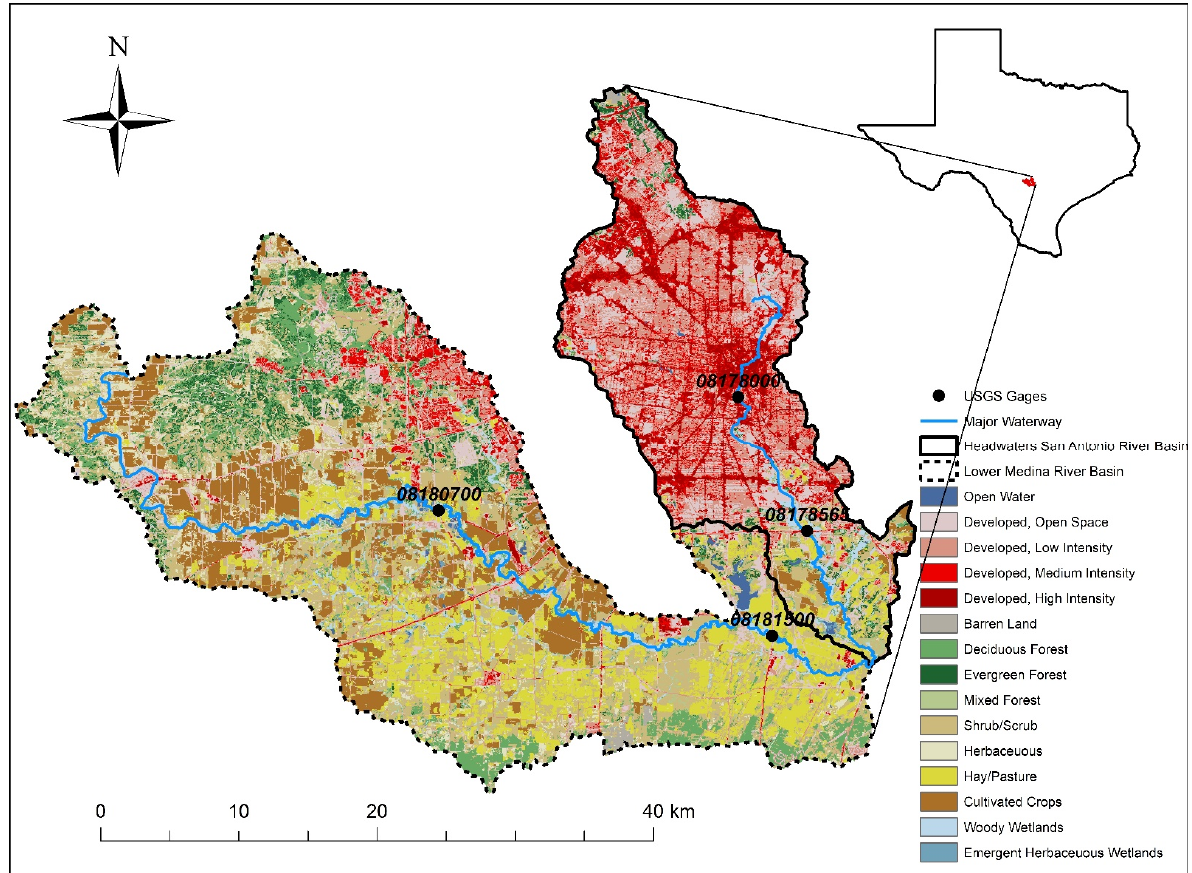
Figure 1. Study Area, the headwaters San Antonio River Basin (HSARB), and the Lower Medina River Basin (LMRB) with NLCD LULC classification and USGS Stream Gages displayed.